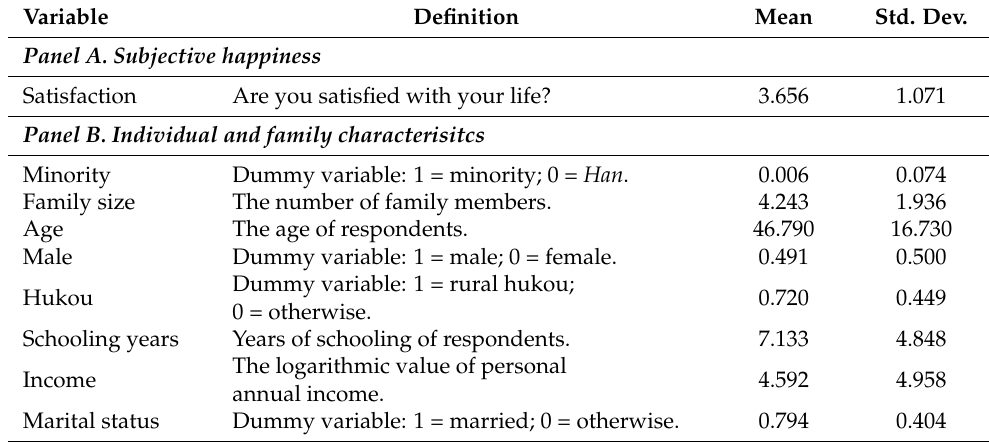
Table 2. Summary statistics of key